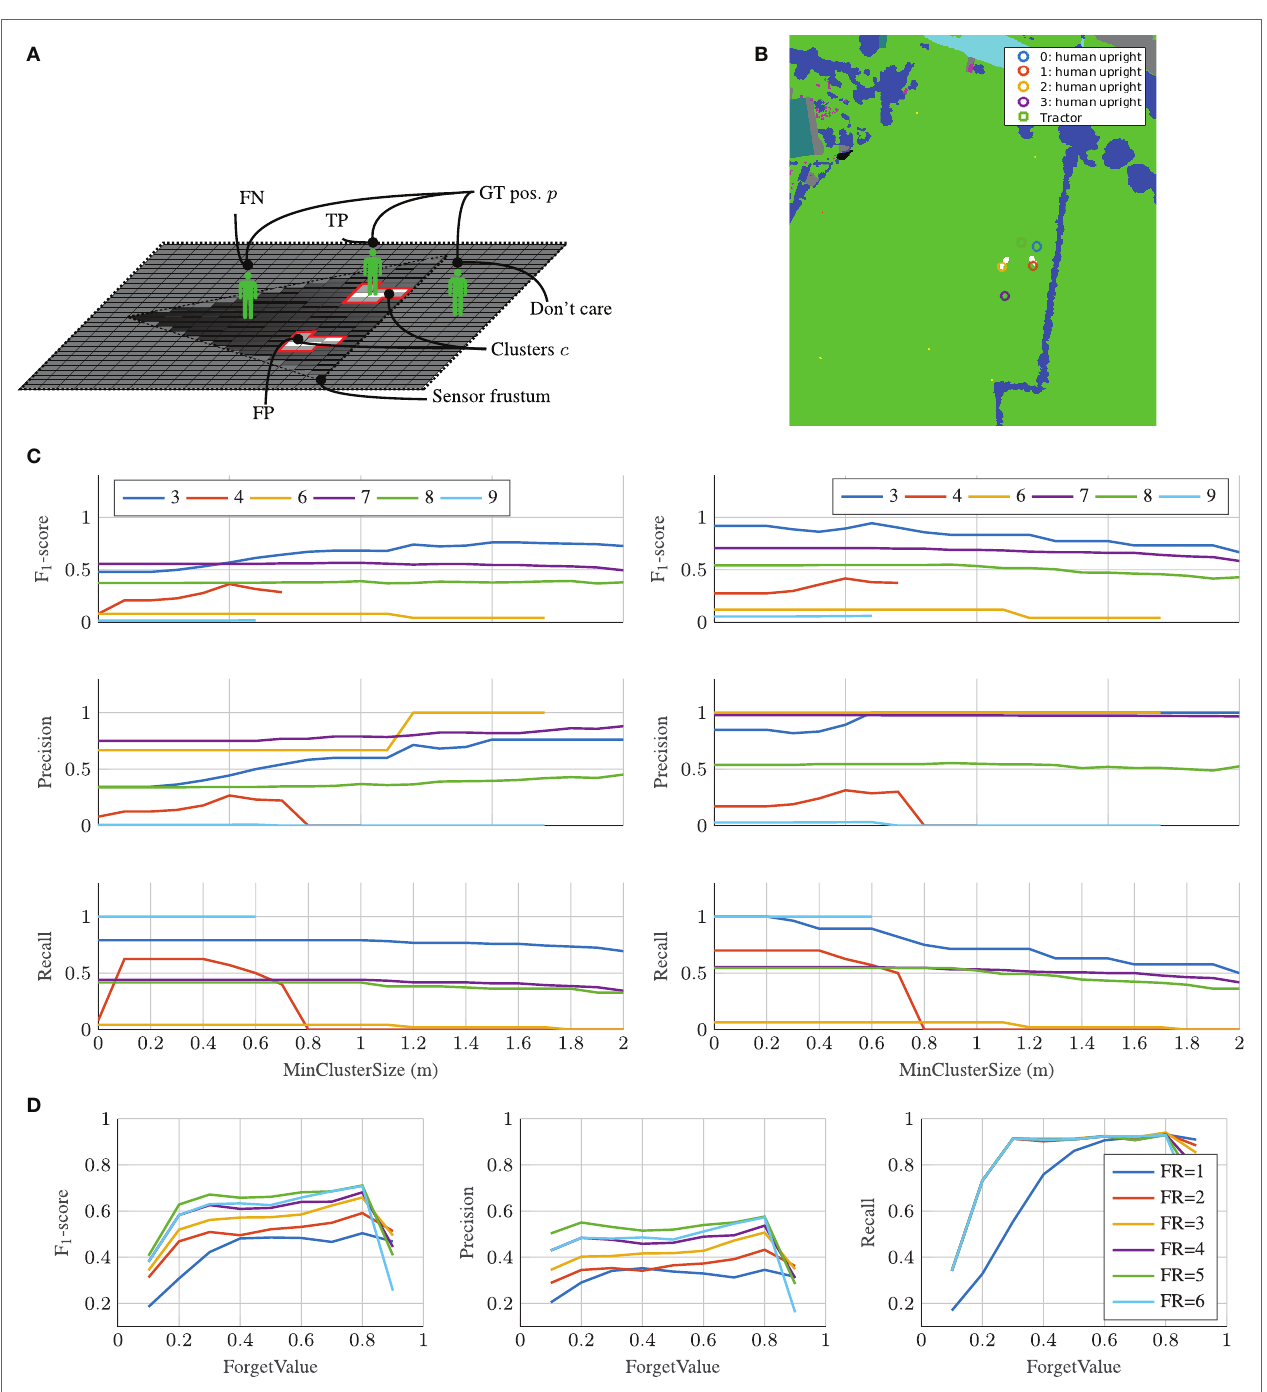
Table 3 . ForgetRate = 6 and ForgetValue = 0:8. Left: No dilation. Right: Dilation by vehicle radius of 2:5m. (D) F 1 -score over increasing ForgetValue with different ForgetRate (FR).